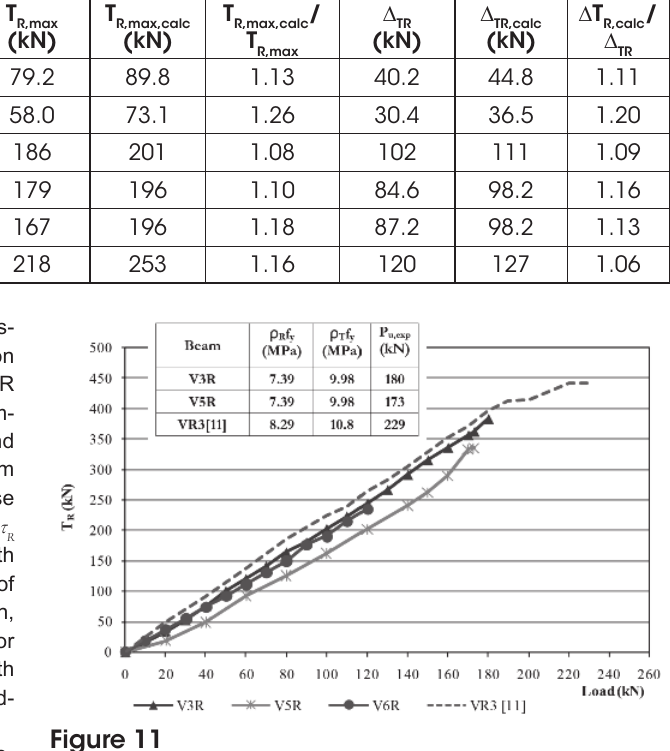
Load - T curves of beams VR3 [11], V3R, V5R and R V6R, with same reinforcement ratio